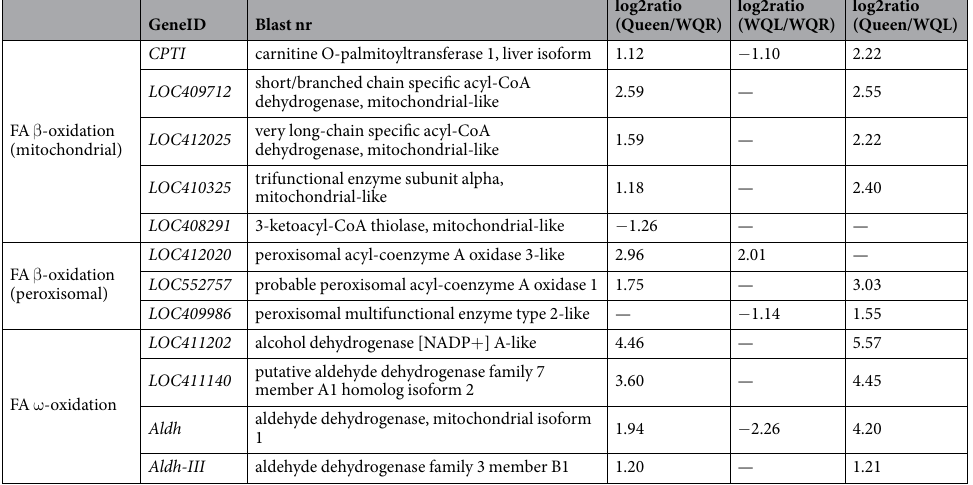
Table 2. Comparison of the differentially expressed genes involved in fatty acid degradation. Blast nr, results of blast against nr database; log2ratio (A/B), RPKM was used to calculate the log2ratio (A/B), positive number means this gene was highly expressed in latter group (B) and negative number means this gene was highly expressed in former group (A), “ − ” means log2ratio does not fit statistical criteria (|log2Ratio| ≥ 1 and FDR ≤ 0.001) and this gene was not differentially